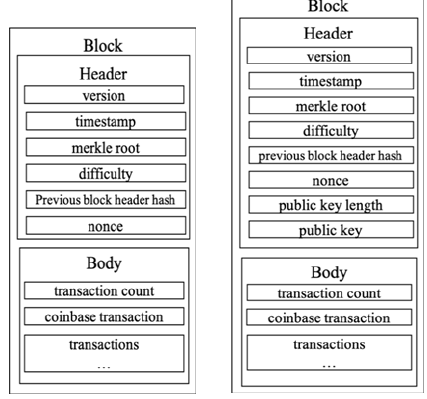
Figure 4. Block structure of Bitcoin blockchain (left) and that of our scheme (right).